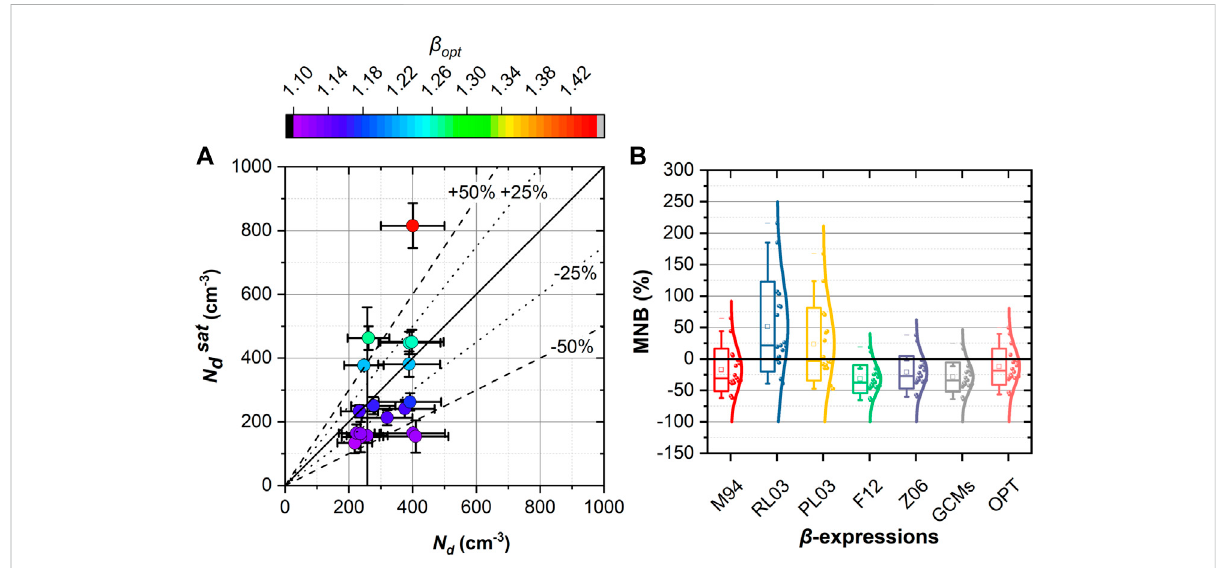
FIGURE 4 (A) Dropletnumberclosurebetween N d and N d sat usingtheOPTcomparedto N d inrespectof β opt onthecolorscale; (B) TheMNBoftheclosure of N d sat _ N d by using each β - expression: (I) M94, ii) RL03, iii) PL03, iv) F12, v) Z06, vi) GCMs, and vii) OPT ,